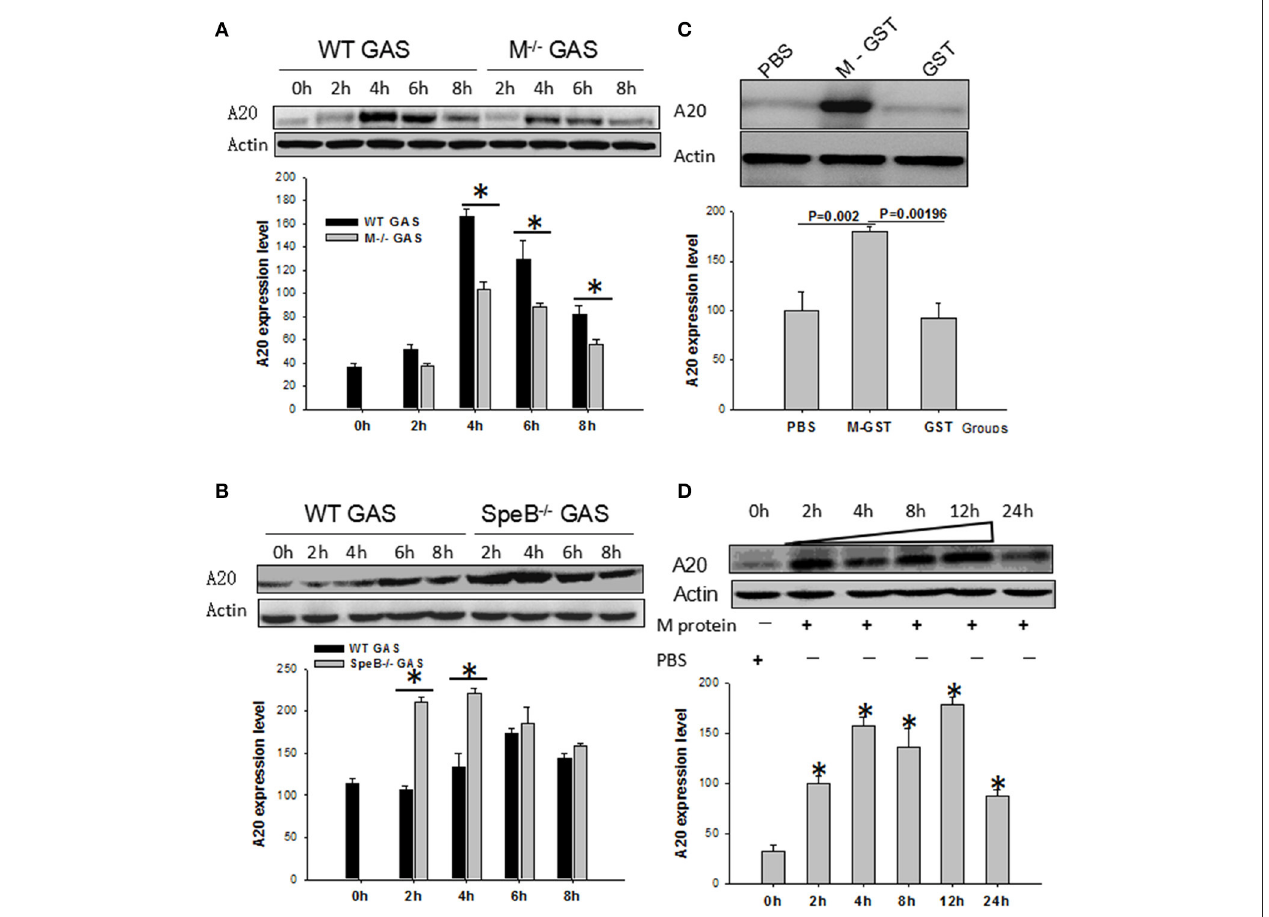
FIGURE 7 | WT RAW cells induced by gene mutant strain M − / − or SpeB − / − GAS, or WT GAS, or purified M protein. RAW cells were stimulated by WT or M − / − (A) or SpeB − / − GAS (B) at an MOI of 10. Six hours later, the treated cells were collected and A20 expression was determined by Western blotting. * P < 0.05 vs. the M − / − GAS group. RAW cells were stimulated by recombinant M-GST protein, GST-tag alone, and PBS as a control (C) , or recombinant purified M protein and PBS as a control (D) . Six hours later, the treated cells were collected and A20 expression was determined by Western blotting. Each experiment was repeated three times, and similar results were obtained on each occasion.